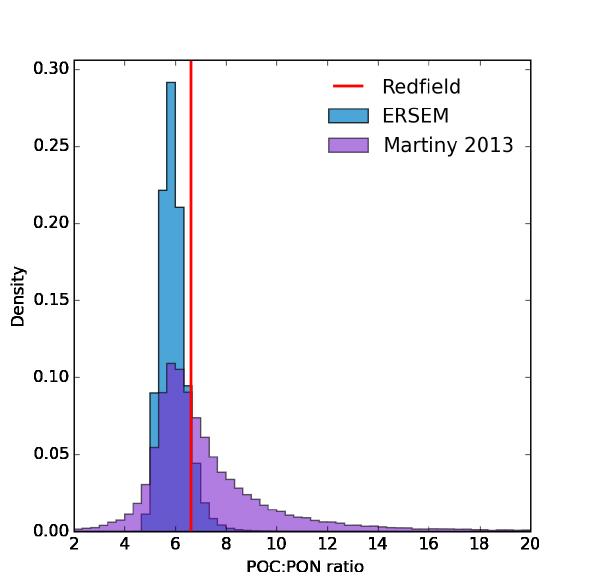
Figure 6. The ratio of particulate organic carbon to particulate or- ganic nitrogen in the Martiny et al. (2013) in situ data set and in the model. The Redfield ratio is also shown as a red vertical line. The model data were taken from a monthly climatology of the top 200m of the final 10 years of running, excluding the Arctic Ocean. Both the ERSEM and the Martiny et al. (2013) histogram were nor- malised to unity